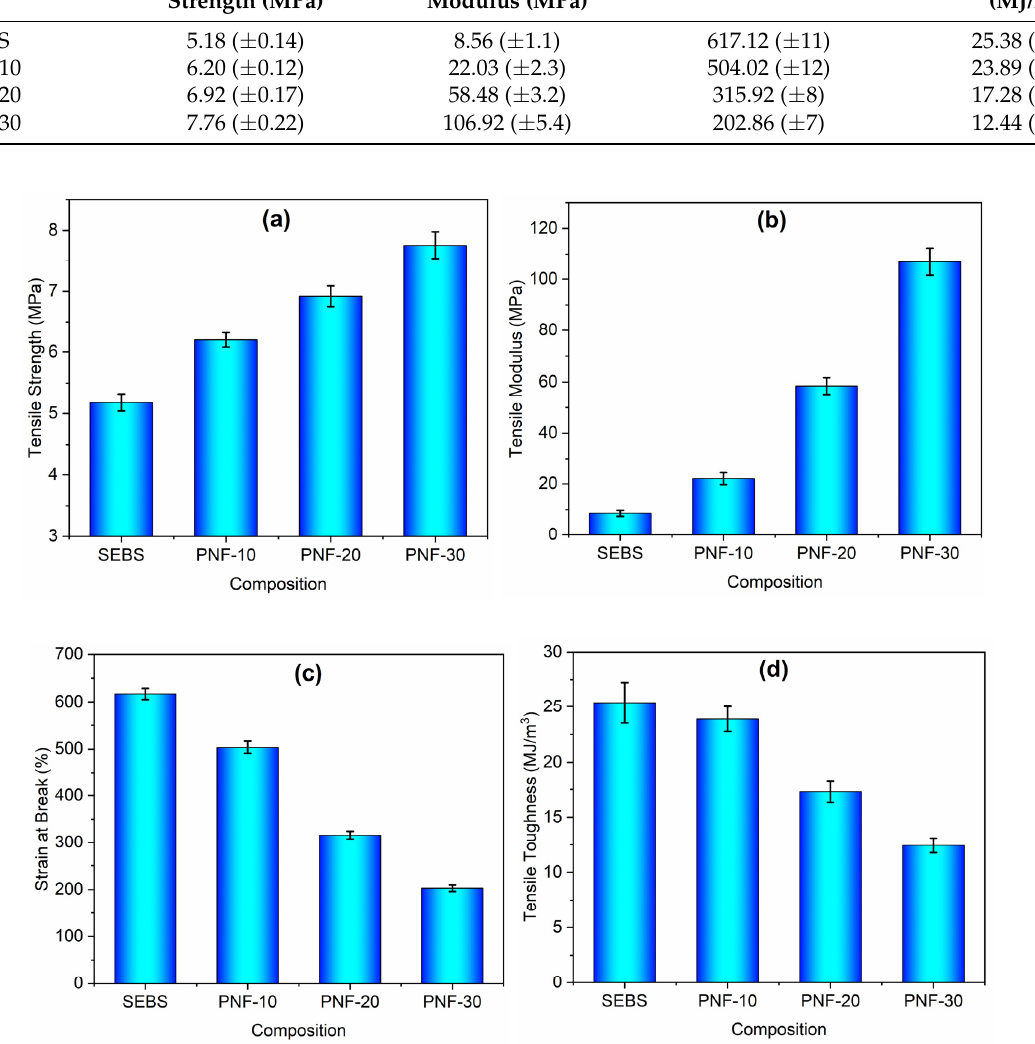
Figure 5. Tensile properties of the PNF/SEBS composites: ( a ) tensile strength, ( b ) tensile modulus, ( c ) tensile strain at break, and ( d ) tensile toughness.